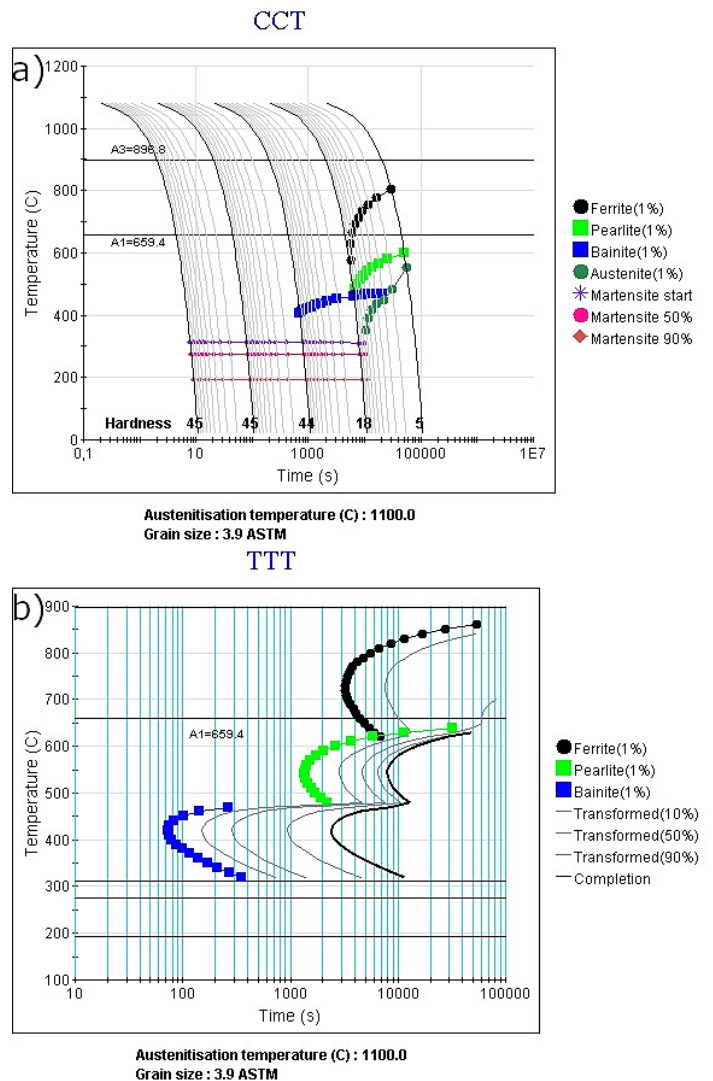
Figure 3. Non-equilibrium diagrams for analyzed steel: ( a ) CCT diagram; ( b ) TTT diagram.